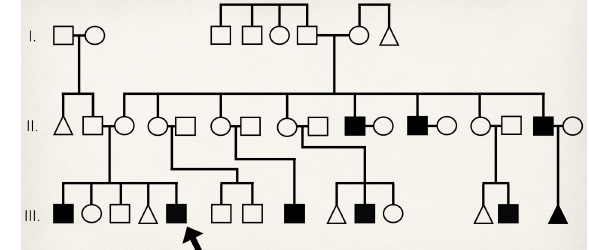
Figure 4: Third-week postoperative gross examination of the right eye